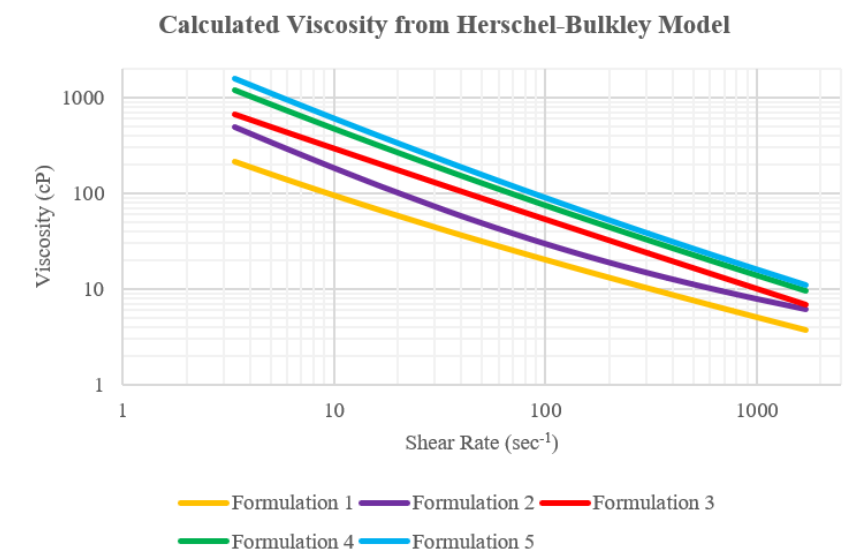
Figure 4: Composite of calculated viscosity using the Herschel-Bulkley model